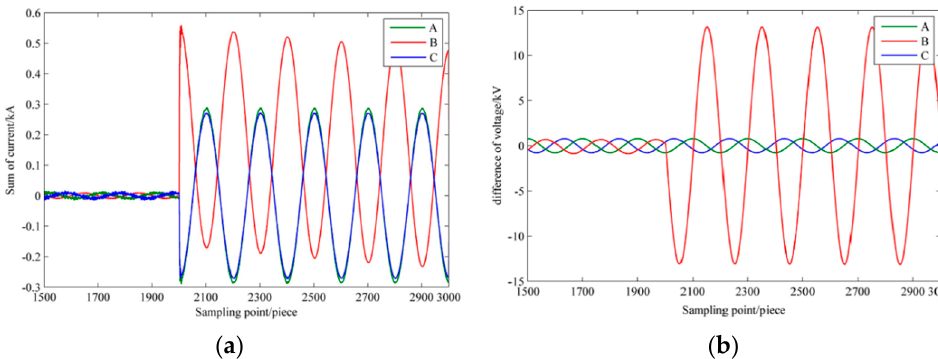
Figure 5. High-resistance grounding fault at 50% of phase B. ( a ) Sum of fault component current. ( b ) The voltage difference of the fault component.